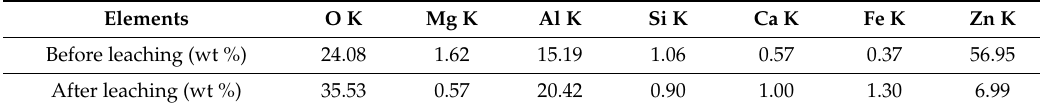
Table 4. Qualitative mapping of elements by EDS on grain surface before and after leaching.